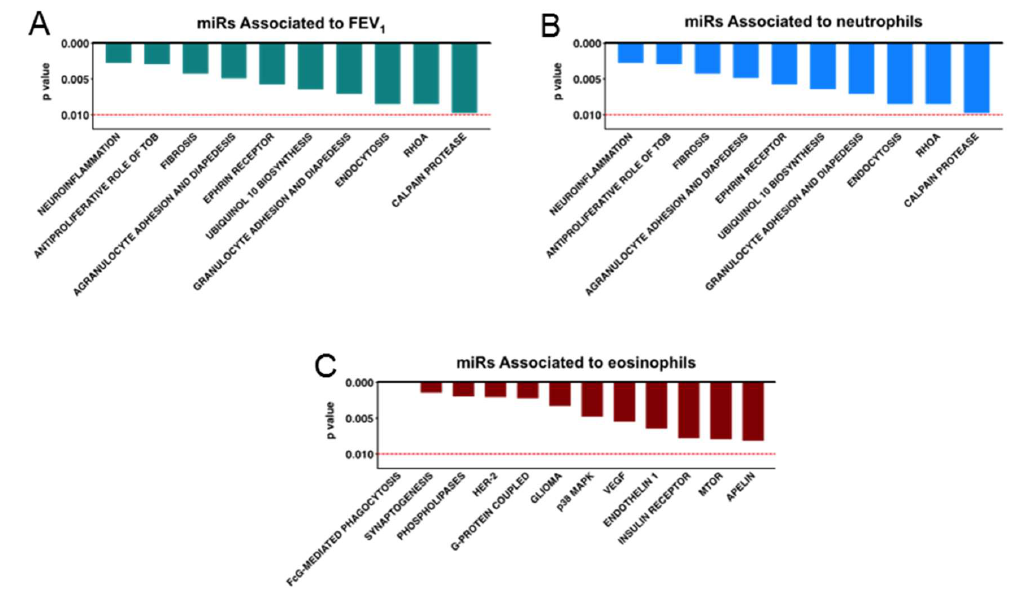
Figure 4. Networks of miRNA target key molecular and cellular pathways related to asthma pathology. Biological pathways were predicted by Ingenuity Pathway Analysis (raw p value less than 0.010) to be a ff ected by microRNAs associated with FEV 1 (( A ), hsa-mir-151a-5p, hsa-mir-202-3p, hsa-mir-202-5p, hsa-mir-568, hsa-mir-625-3p), neutrophilic inflammation (( B ), hsa-mir-224-5p, hsa-mir-151a-5p, hsa-mir-581), and eosinophilic inflammation (( C ), hsa-mir-10b-5p, hsa-mir-151a-3p, and hsa- mir-615-3p).